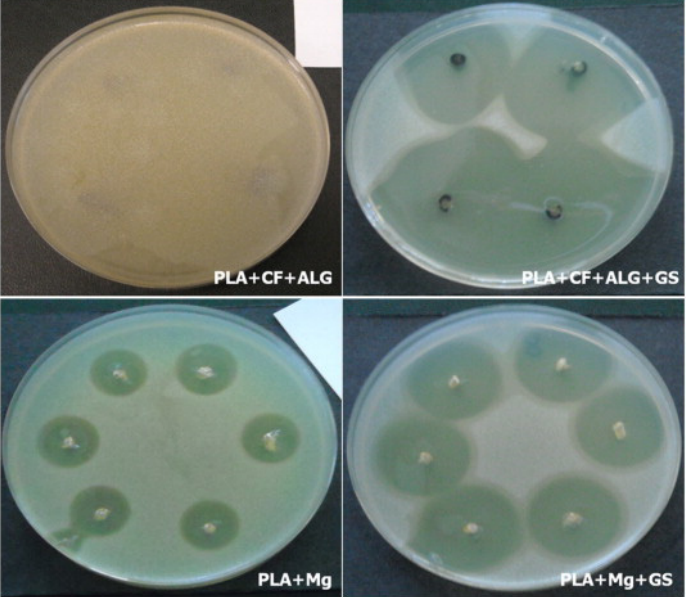
Figure 18. Inhibiting effect of the nails with a gentamicin addition by the growth of the methicillin- sensitive Staphylococcus pseudintermedius strain (culture after 48 h of incubation) [69] . Reprinted with permission from ref. [69] . © 2021 Elsevier.